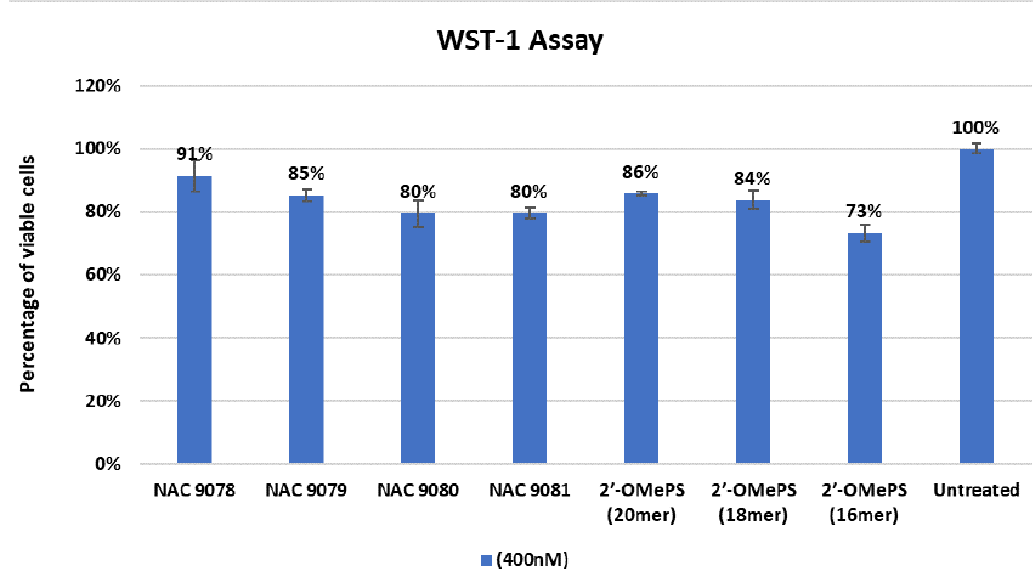
Figure 6. Percentage of viable cells observed after transfection quantified using a WST-1 assay (Error bars represent the standard deviation of mean).